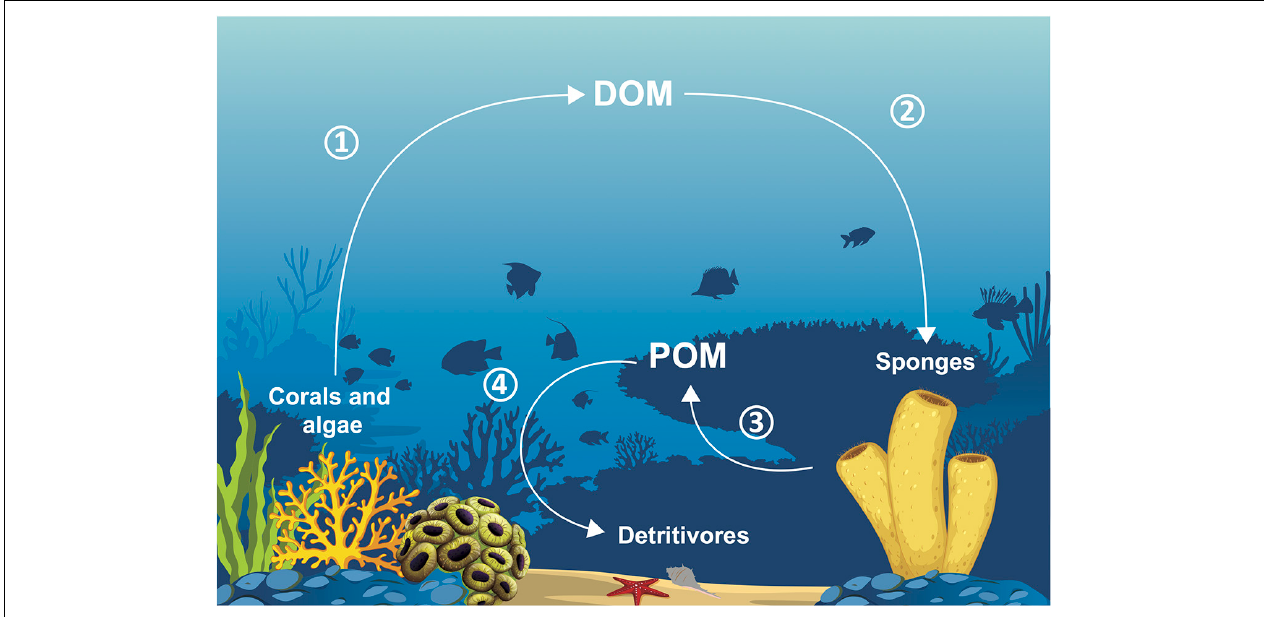
FIGURE 3 | Sponge loop: (1) corals and algae excrete dissolved organic matter (DOM), (2) DOM is taken up by sponges, (3) sponges release detrital particulate organic matter (POM), (4) POM is ingested by